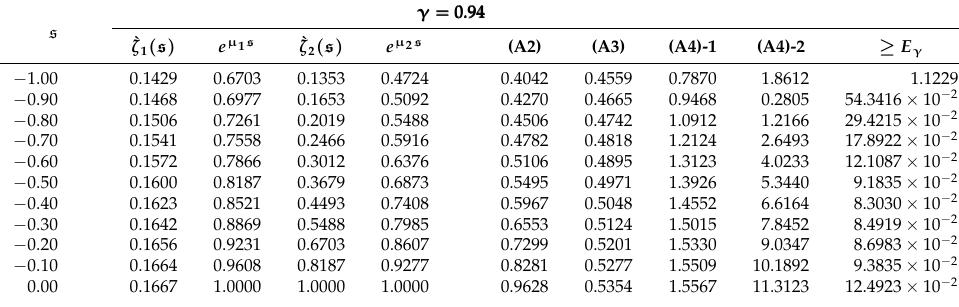
Table 4. Numerical results of (A1)–(A4) of the Gilpin–Ayala competition predator-prey system with harvesting terms (24) whenever γ =